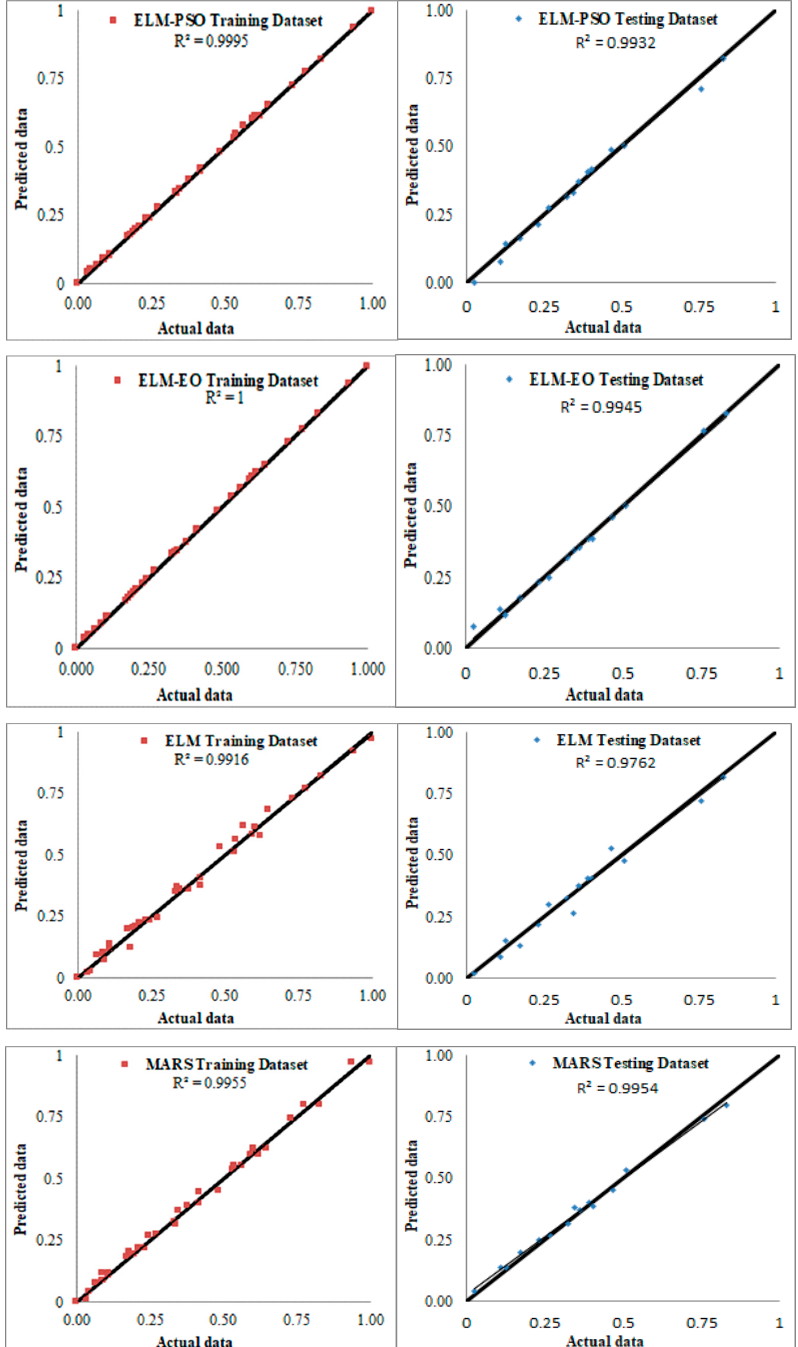
Figure 2. Scatter plot of the applied models .